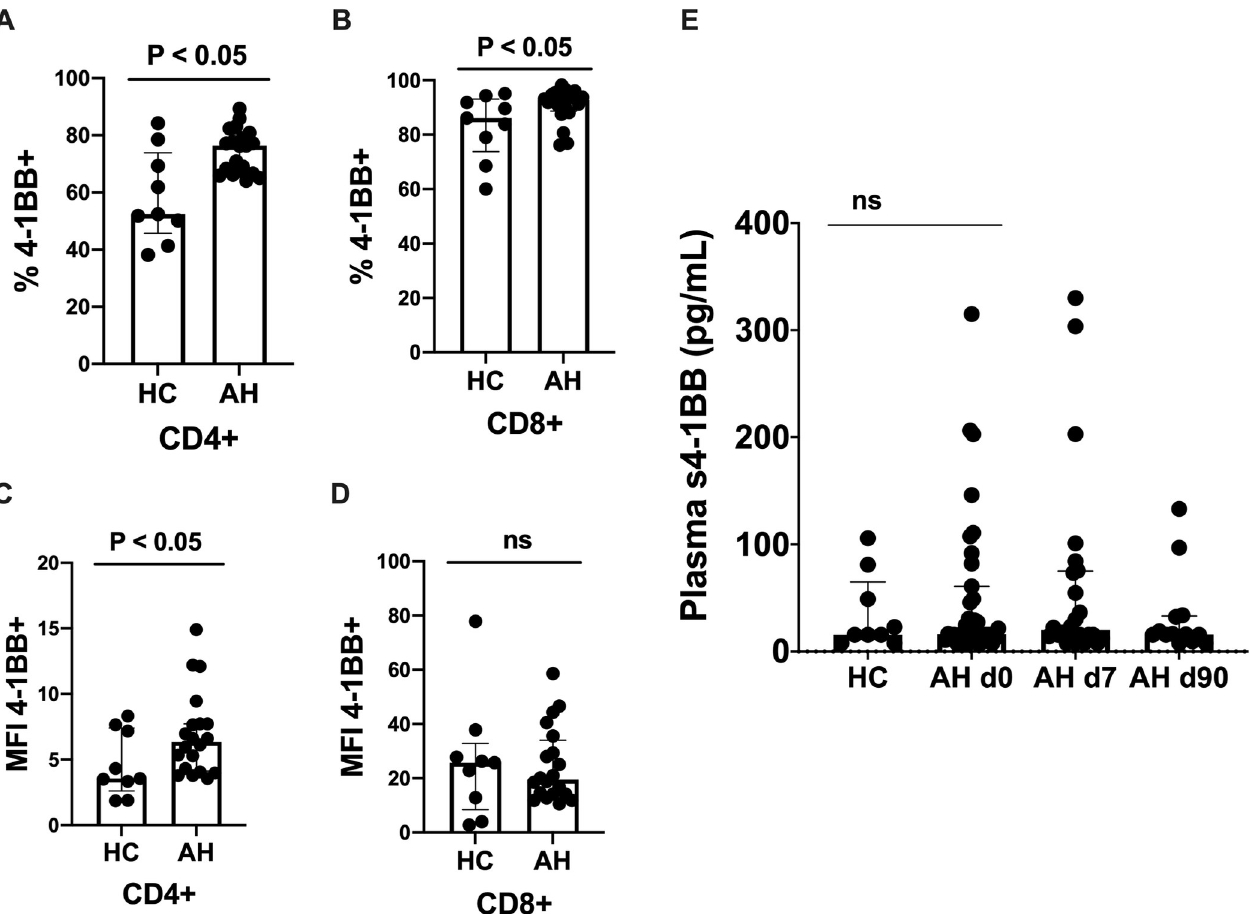
Fig 1. High expression of 4-1BB on T lymphocytes. Peripheral blood mononuclear cells were stimulated for 48 hours with anti-CD3 and anti-CD28. The frequency of (A) 4-1BB + CD4 + and (B) CD8 + T lymphocytes are measured by flow cytometry and compared between patients with alcoholic hepatitis (AH) at diagnosis and healthy controls (HC). The median fluorescence intensity (MFI) of (C) 4-1BB + CD4 + and (D) CD8 + T lymphocytes are compared between AH patients and HC. (E) Plasma soluble (s) 4-1BB was measured with enzyme-linked immunosorbent assay (ELISA) in HC and AH at diagnosis (day 0), day 7, and day 90. Median ± interquartile range shown. T